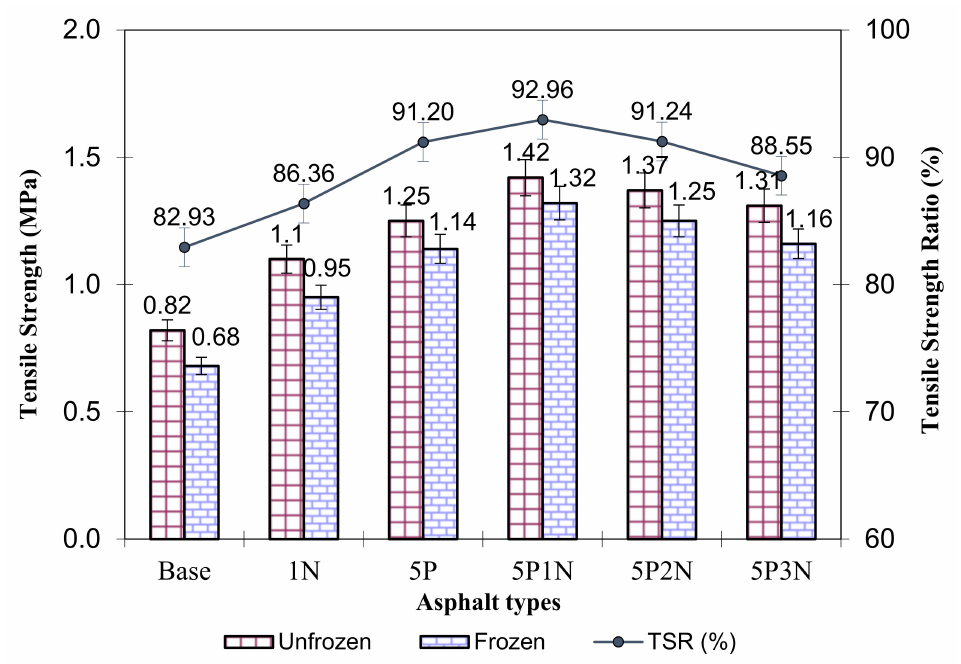
Figure 9. Results of moisture susceptibility